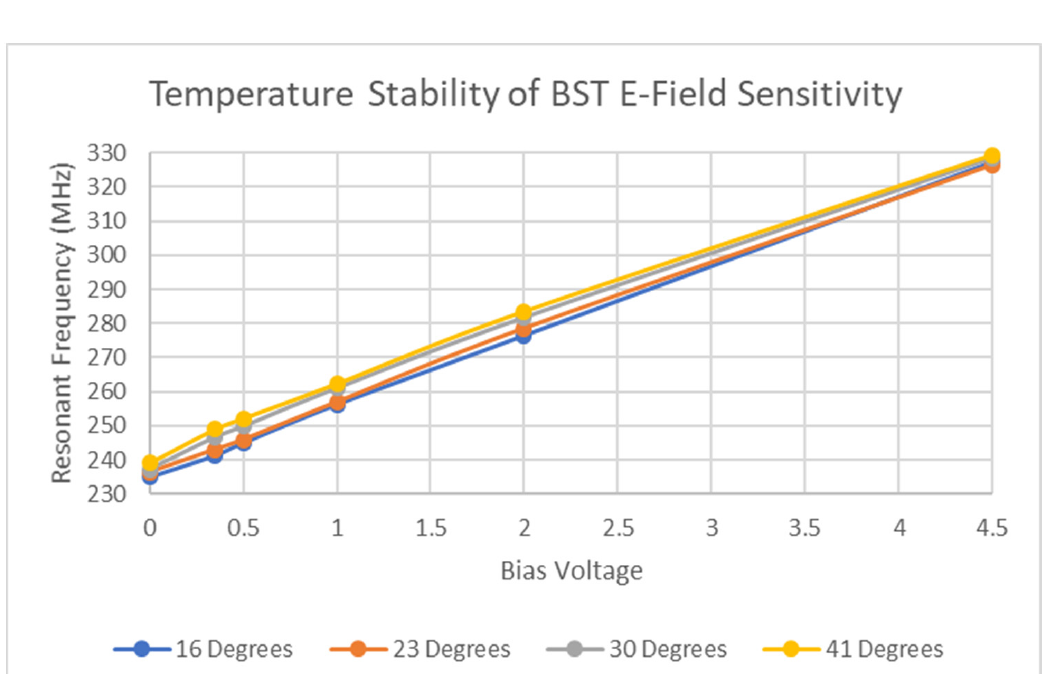
Figure 7. Temperature analysis of tag sensitivity.